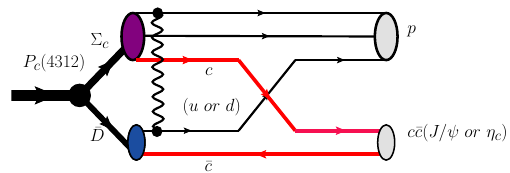
Fig. 1 Schematic diagram for the hidden charm decay P c ((cid:2) c + ¯ D ) → p + J /ψ(η c ) with the quark re-arrangement. The wiggle line stands for the interaction between two quarks in the meson and baryon clusters, respectively. The thin-black and red-thick lines represent the light and heavy quarks,